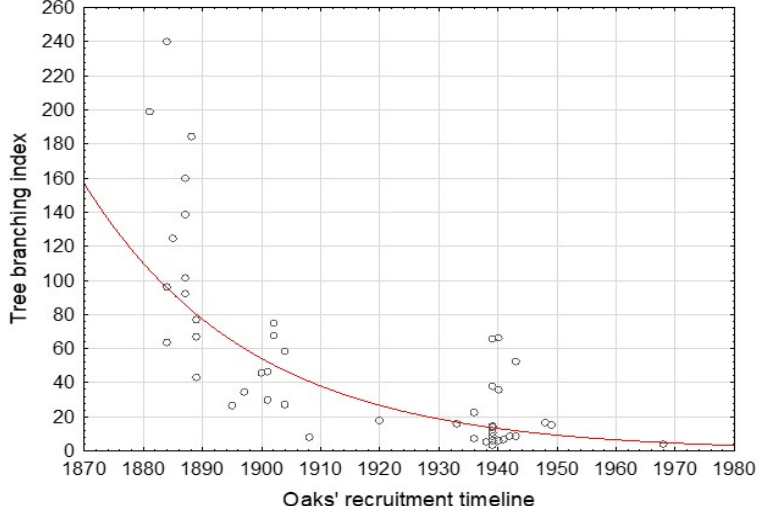
Figure 6. Exponentially decreasing oaks’ tree branching index based on the data from 46 cored oaks; r = − 0.702.